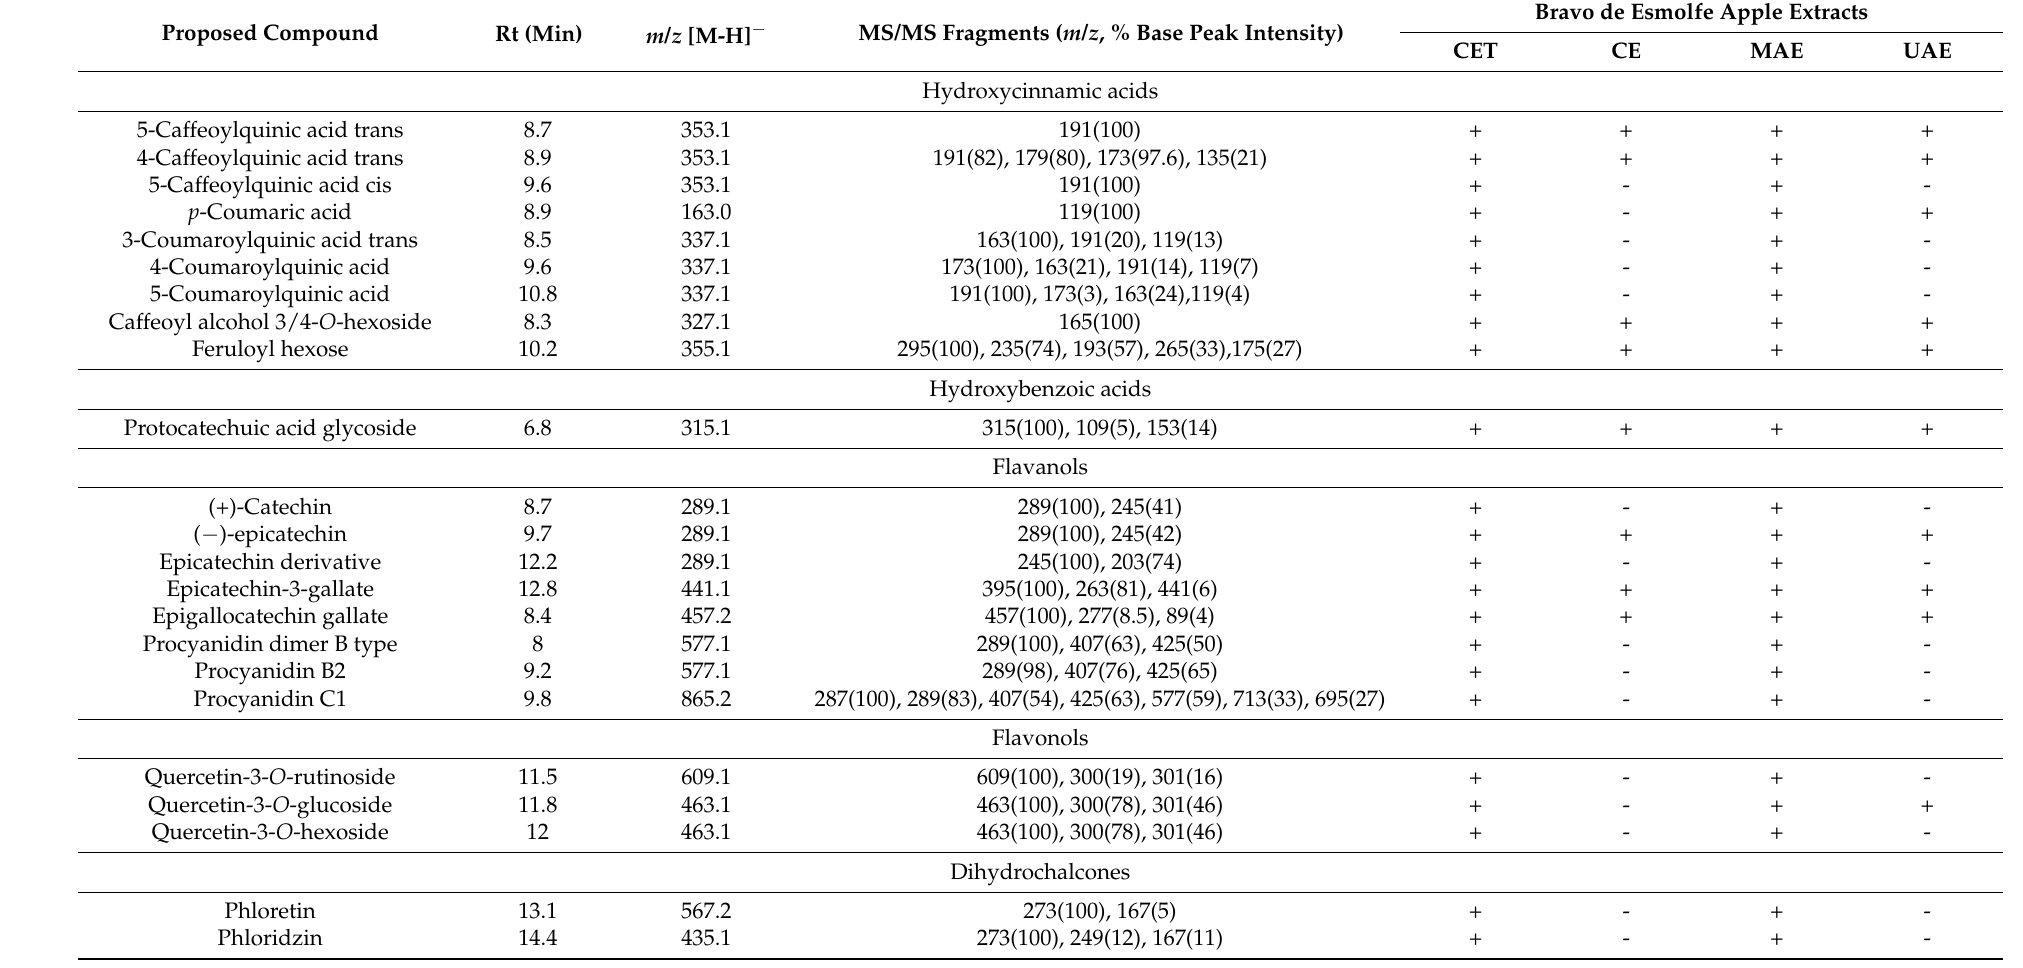
Table 2. Phenolic compounds identified (or tentatively identified) by LC-ESI-UHR-QqTOF-MS in different ‘Bravo de Esmolfe’ apple